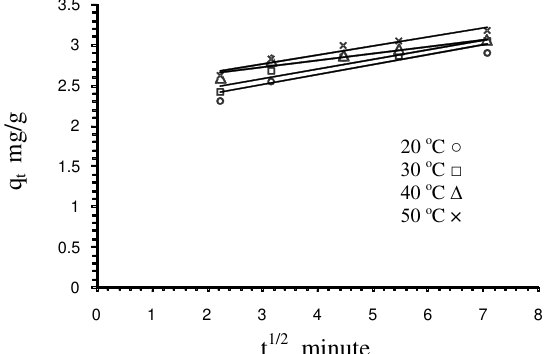
Figure 13 . Intraparticle diffusion plot for Cr(VI) 10 mg/L adsorption onto MPGP 2 g/L, pH 2 at different time and